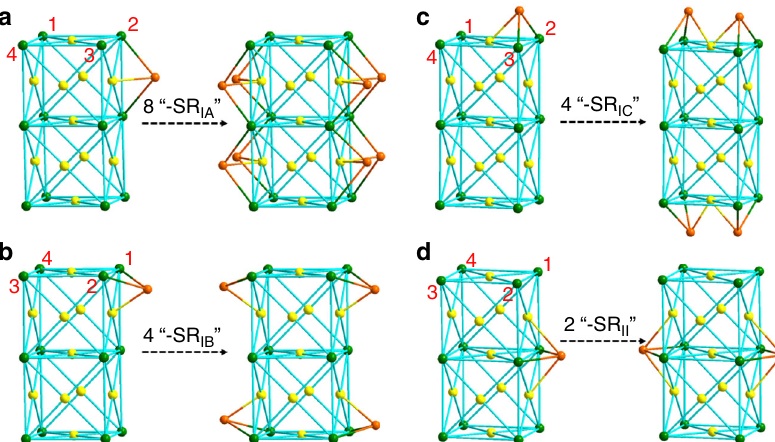
Fig. 3 Binding patterns of thiolate ligands in subcategories. For the ease of visualization, the ideal structure (without twist) of Ag 23 is used, and four top vertices of the supercell are labeled by numbers